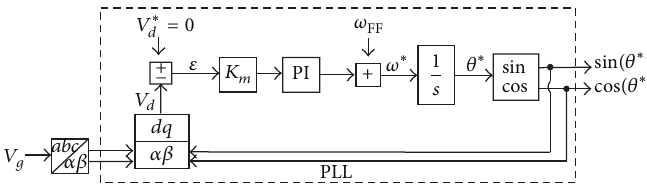
Figure 3: Schematic of the phase-locked loop for grid phase tracking.